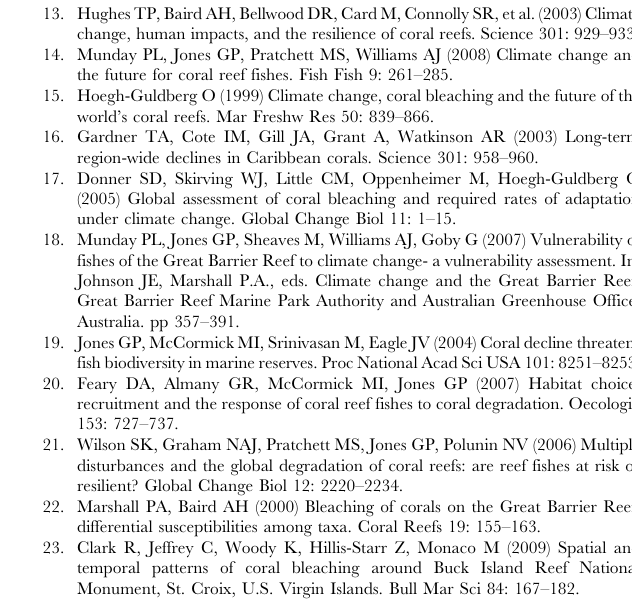
Figure S1 Overall size frequency distributions of newly metamorphosed Pomacentrus amboinensis placed in pairs onto habitat patches to examine habitat-related size selection. Individ- uals with each pair differed in size by 0.8–1 mm standard length. Found at: doi:10.1371/journal.pone.0007096.s001 (3.48 MB